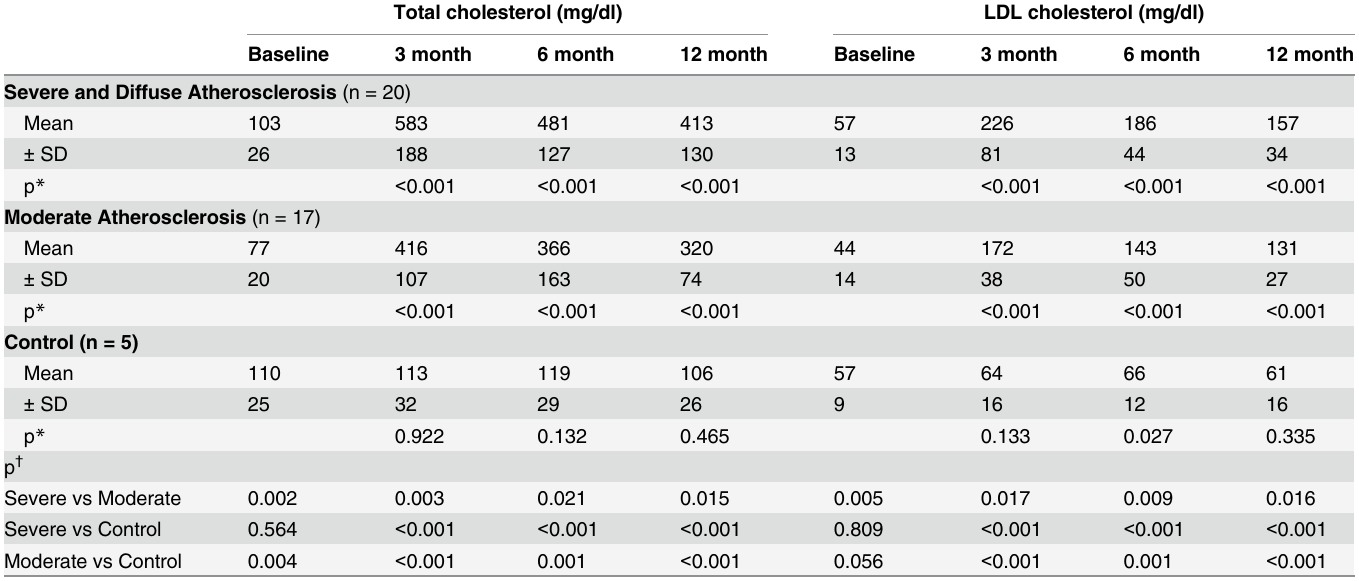
Table 6. Fasting Total and LDL Cholesterol.